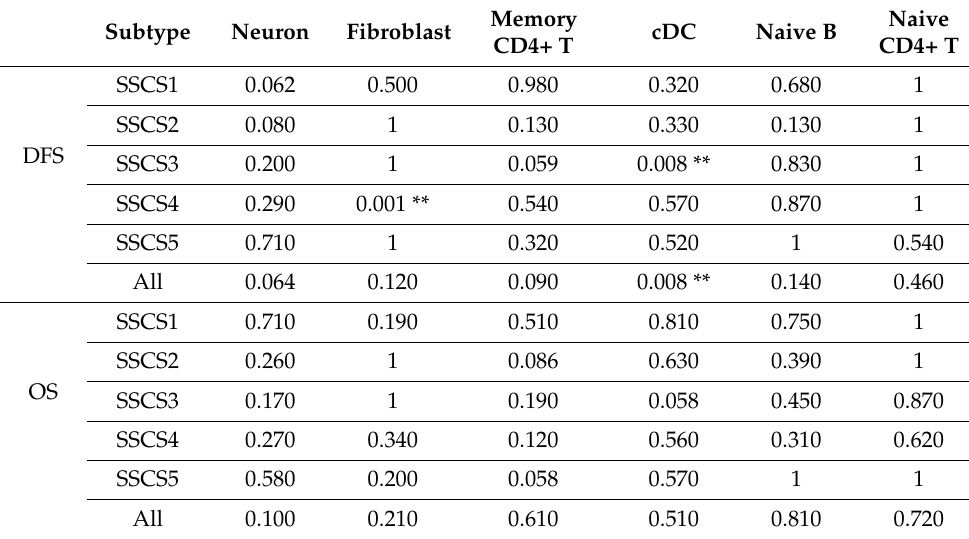
Table 2. Log rank p -values from survival analysis for the six TME cell